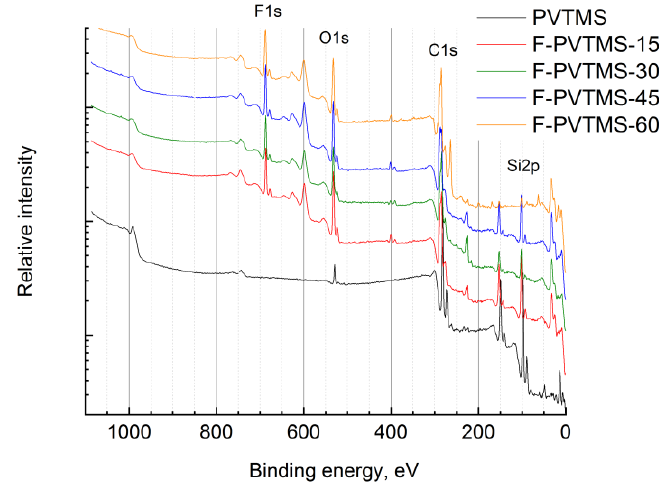
Figure 5. The overall XPS spectra of the surface of the virgin and the fluorinated PVTMS samples.